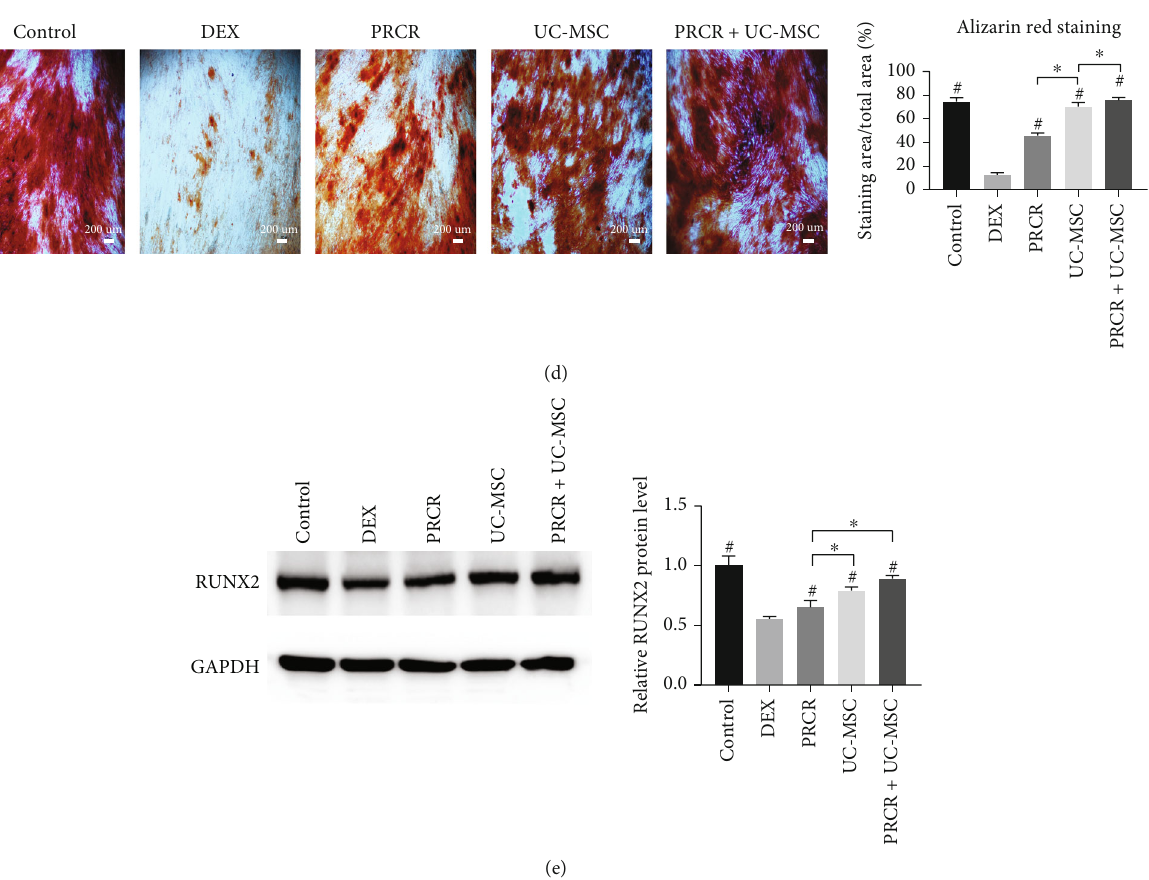
Figure 2: In vitro e ff ects of PRCR, UC-MSCs, and PRCR + UC-MSCs on the proliferation, migration, and osteogenesis di ff erentiation of DEX-treated BMSCs in the coculture systems. (a) Cocultured with PRCR, UC-MSCs, and PRCR + UC-MSCs, the cell viability of DEX- treated BMSCs was examined by CCK-8 assay. The treatment groups, including the PRCR, UC-MSC, and PRCR + UC-MSC groups, signi fi cantly promoted the BMSC proliferation inhibited by DEX ( P < 0 : 05 ). (b) Migration activities of DEX-treated BMSCs